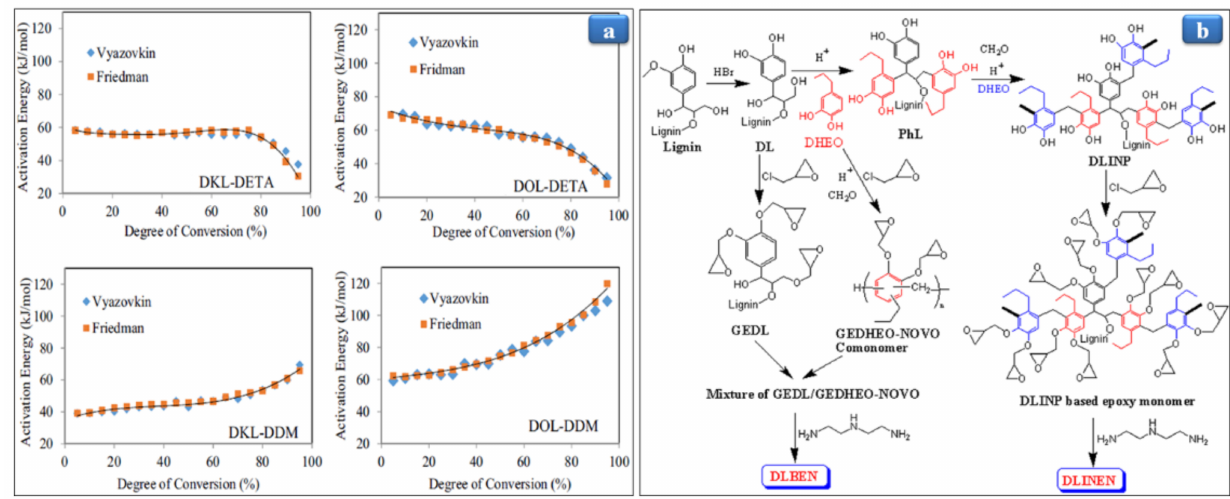
Figure 3. ( a ) The activation energy behaviors of the curing reaction versus conversion. Adapted from Ref. [56] with permission from Elsevier. ( b ) Schematic representation of demethylated lignin phenol-based epoxy monomer and